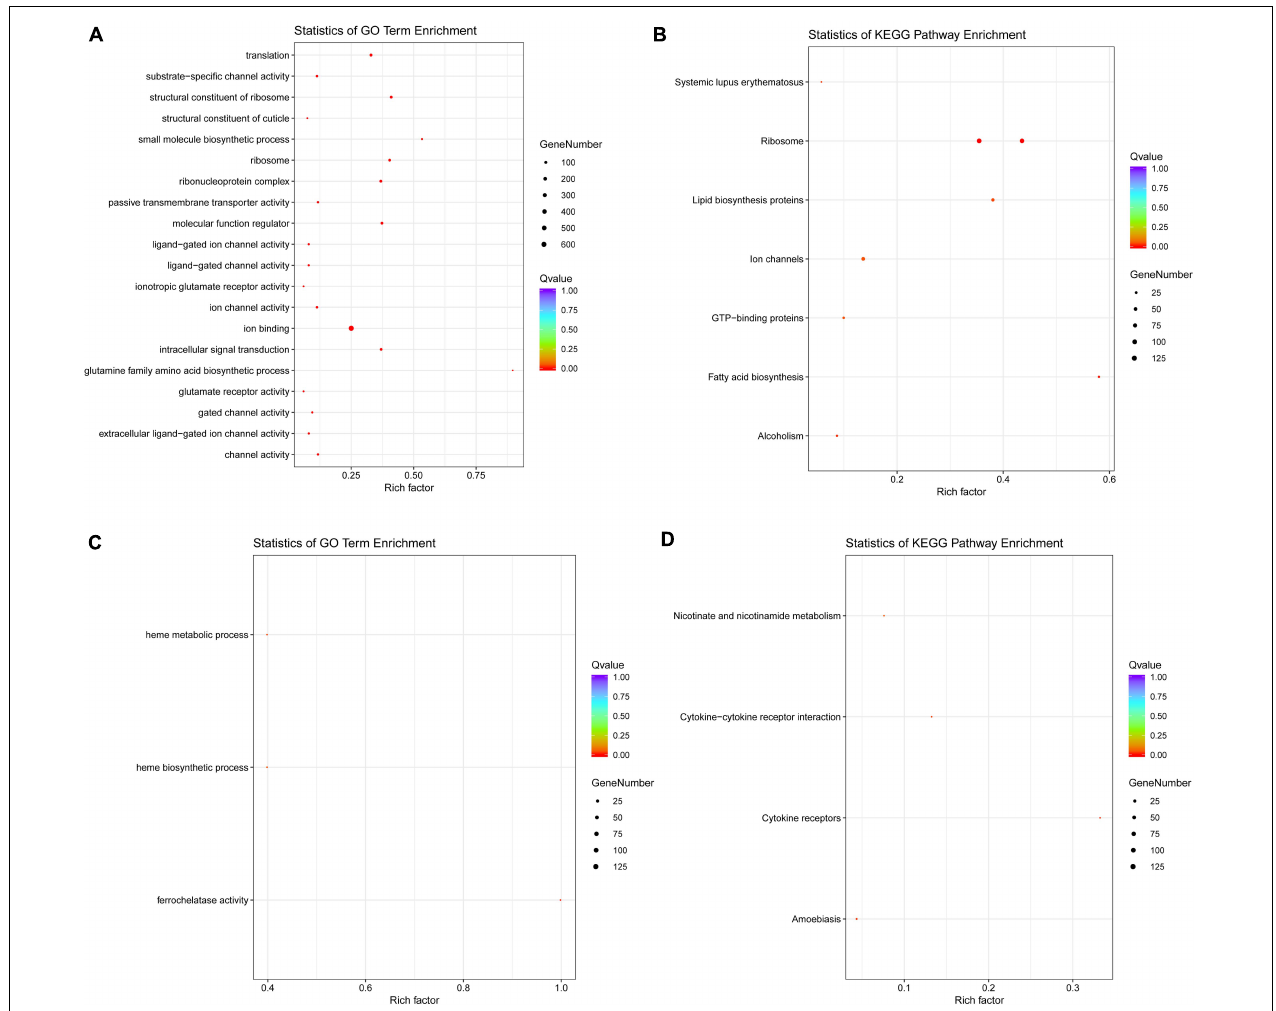
FIGURE 10 | The GO and KEGG annotation of DEGs. The GO (A) and KEGG (B) annotation of DEGs from Ov0 vs. Ov4, and the GO (C) and KEGG (D) annotation of DEGs from Te0 vs.